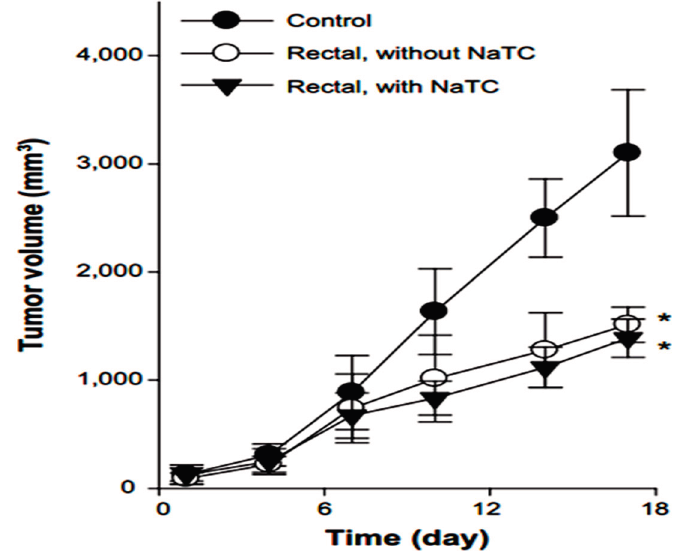
Figure 5. Anti-tumor efficacy of DCT-loaded nanomicelles with and without NaTC after rectal administration [88].* Significantly smaller than control group ( p <